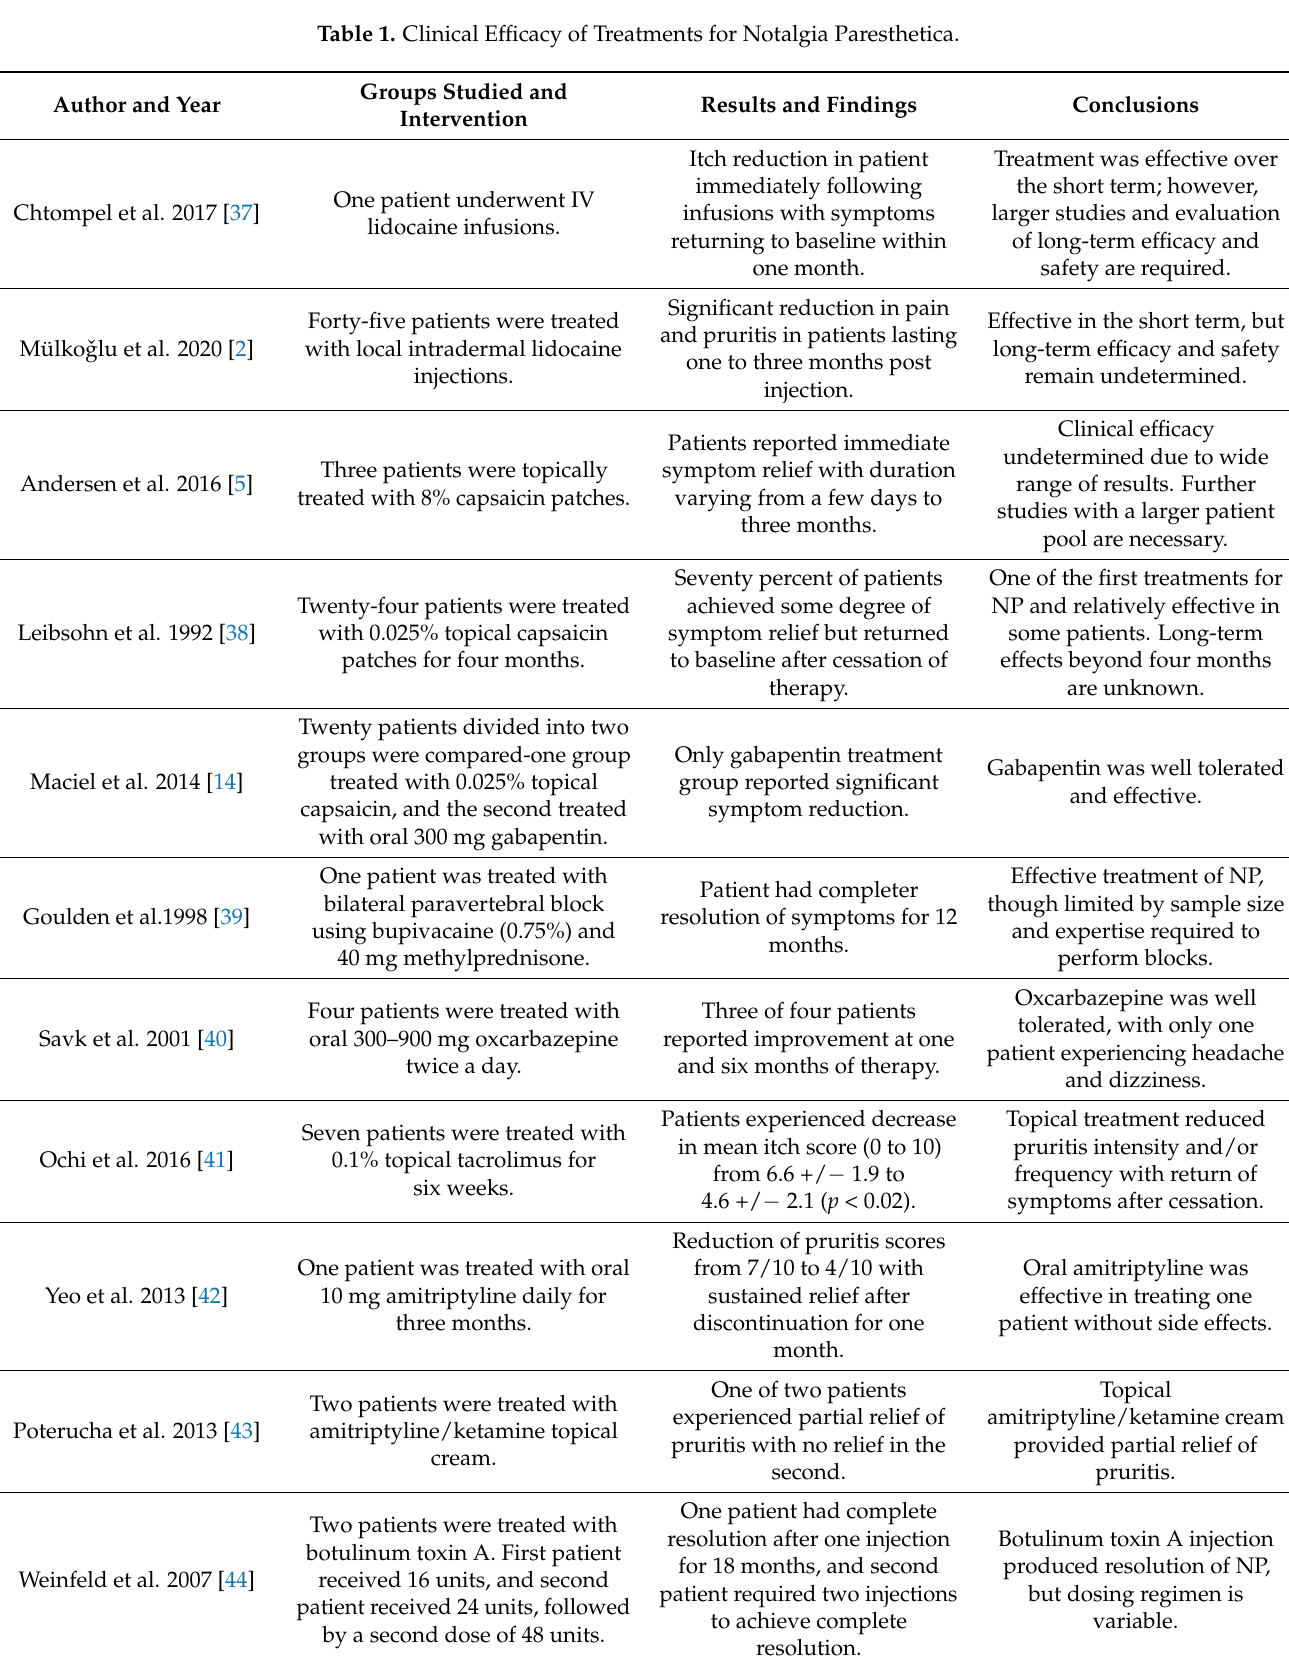
Table 1. Clinical Efficacy of Treatments for Notalgia